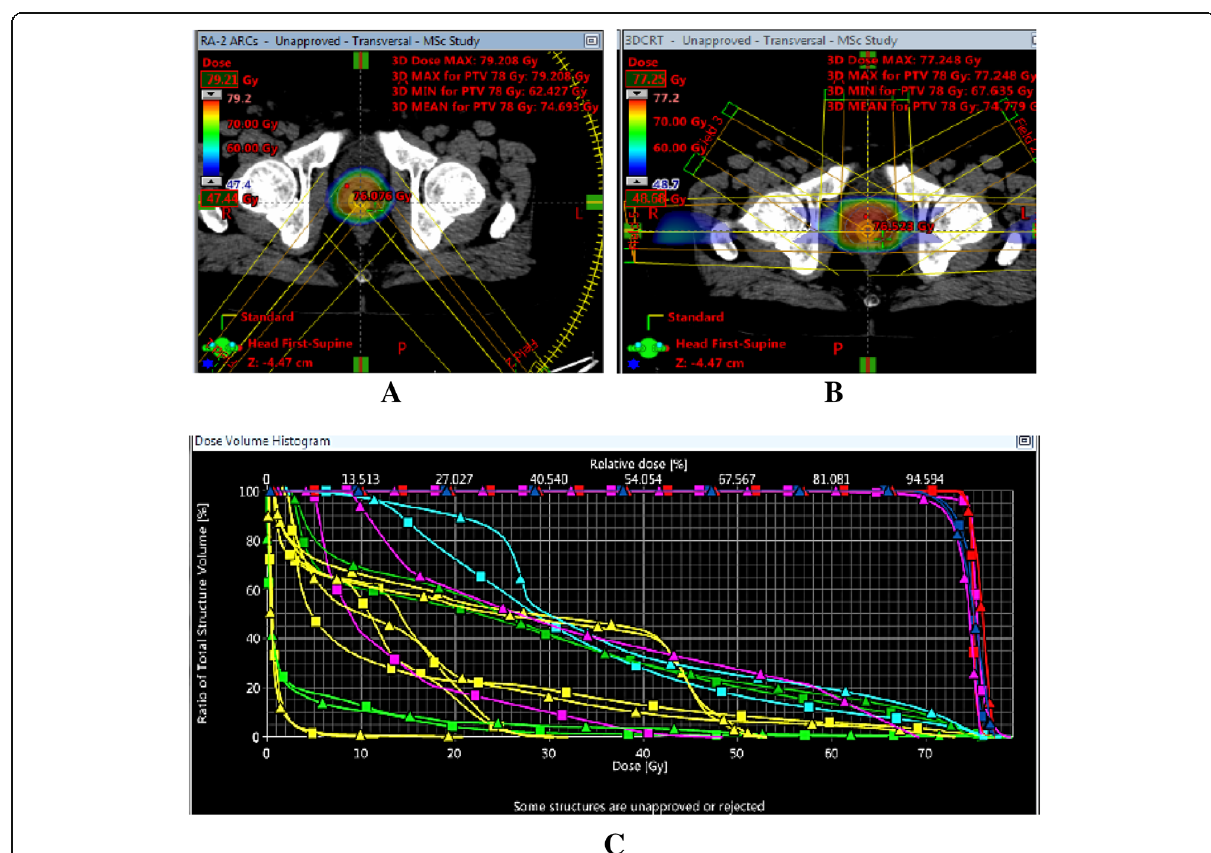
Fig. 2 Both a RapidArc plan and b 3DCRT plan were evaluated according to c dose-volume histogram (DVH) comparison displaying all organs (PTV, rectum, bladder, Rt femoral head, and Lt femoral